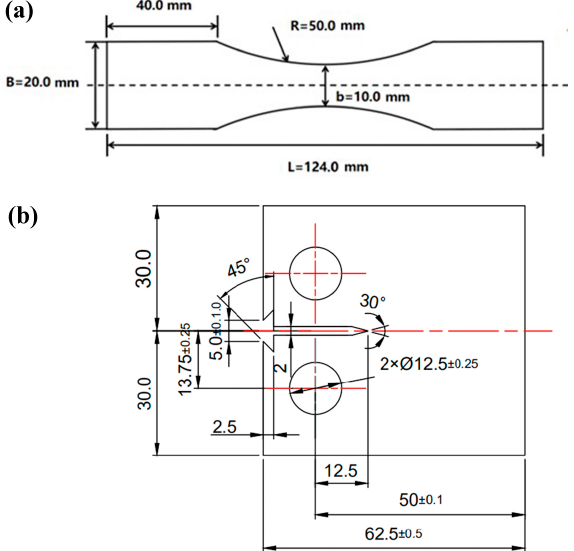
Figure 2. Geometry and dimensions of high cycle fatigue test specimen ( a ) and fatigue crack growth rate test specimen ( b ).